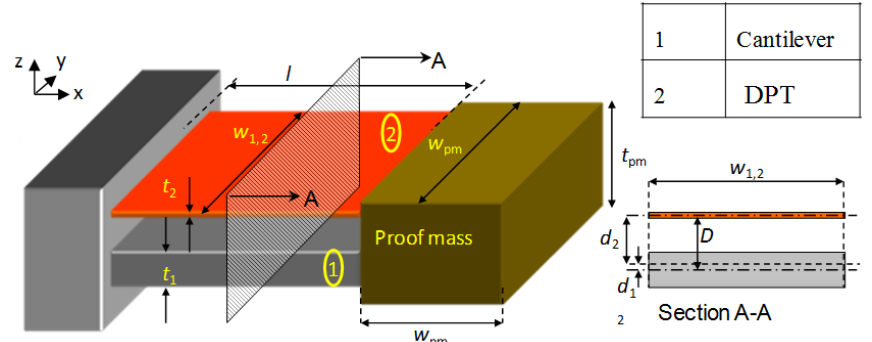
Figure 9. Schematic diagram of the vibration-based energy